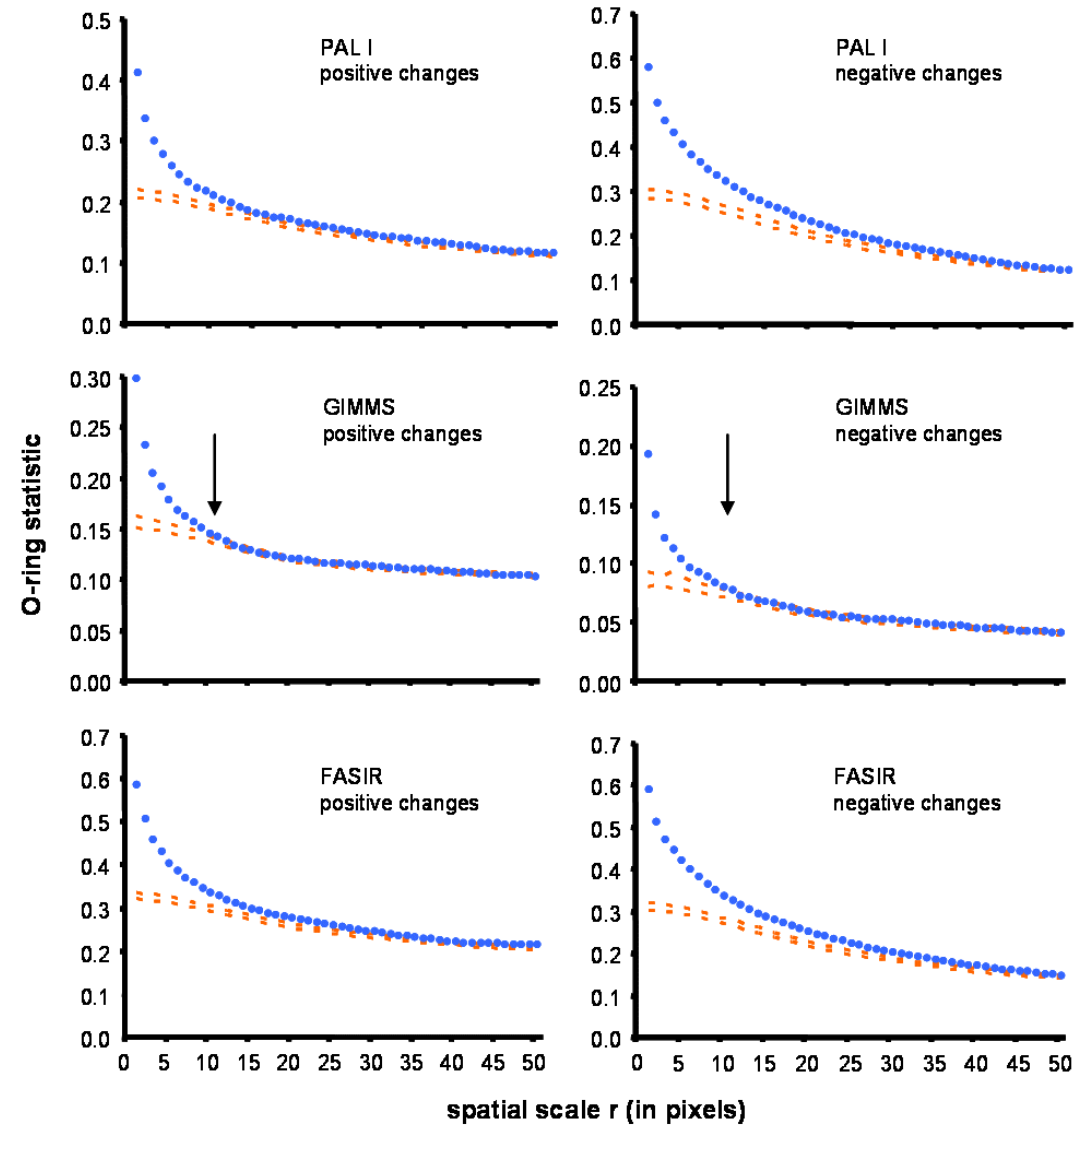
Figure 4. Spatial association of positive and negative changes showed in FASIR, GIMMS, and PAL series based on the O-ring function. Blue dots indicate the observed pattern and orange dashed lines corresponded to 95% confidence bands for a null random model generated by Monte Carlo simulations. Observed values above the orange indicate aggregation. Arrows indicate the scale at which observed patterns converge with the null model (FASIR and PAL arrows are beyond the shown x